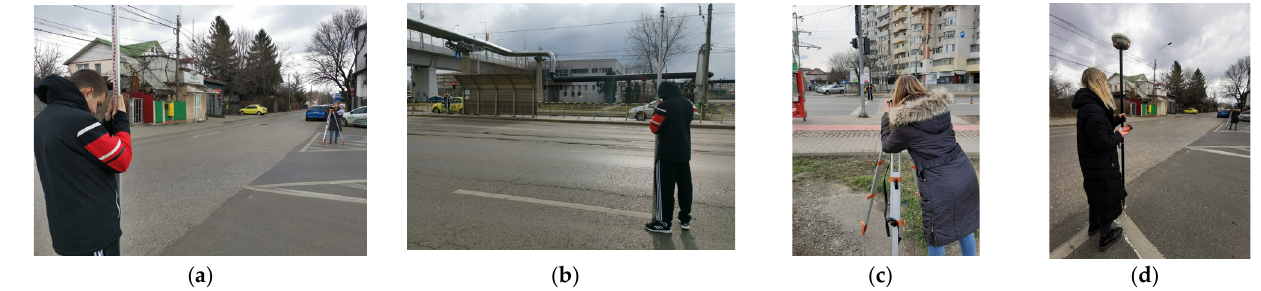
Figure 11. Example of GNSS-RTK and leveling measurements: ( a , b ) leveling measurement of a new point representing road marking; ( c ) leveling measurement of a new point representing pedestrian crossing; ( d ) GNSS-RTK measurement of a new point representing road marking.